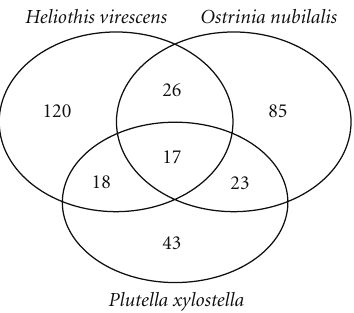
Figure 3: Venn diagram showing the total number of genes used for BAC isolation and those corresponding among the three